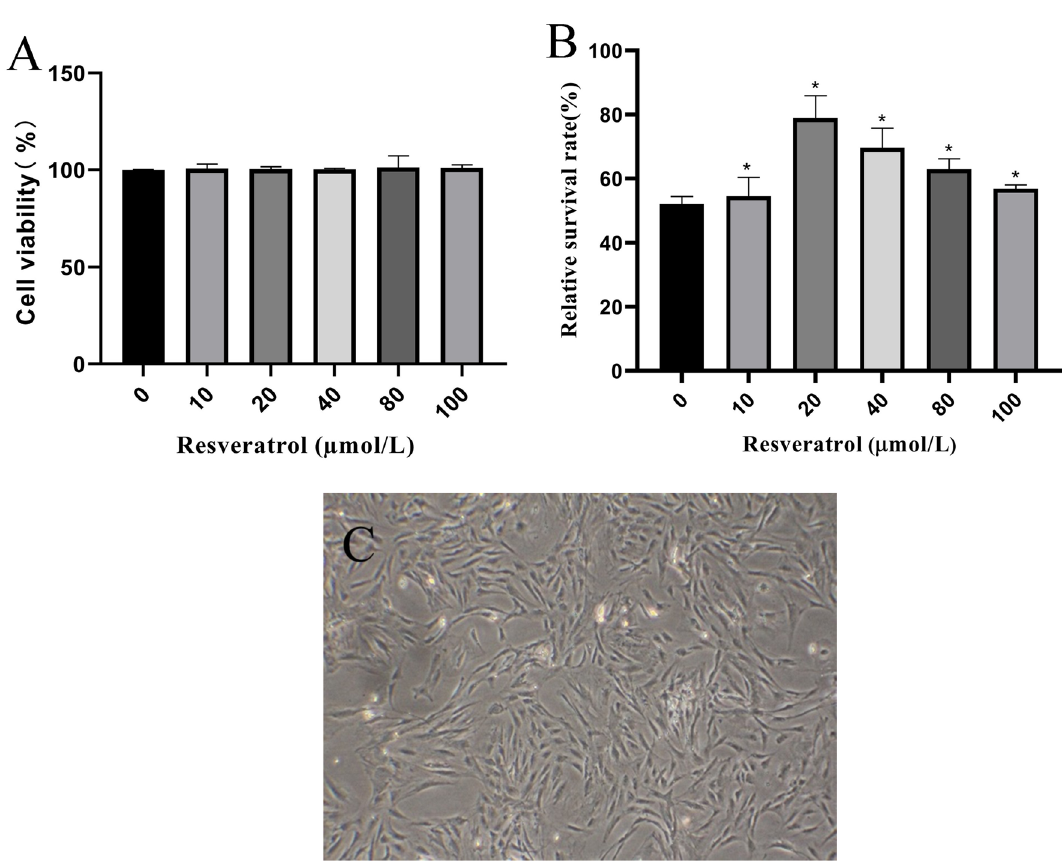
Figure 4. Drug concentration of ADSCs pretreated with Res (× 100). ( A ) Dynamic changes after 24 h of ADSCs treatment with different concentrations of Res (0, 10, 20, 40, 80 and 100 μM). ( B ) Effects of Res (0, 10, 20, 40, 80 and 100 μM) on cell viability in ADSCs induced by H 2 O 2 . ( C ) Resveratrol pretreated ADSCs for 24 h. * P < 0.05 compared with the control group, n = 5; # P < 0.05 compared with the 10 μM